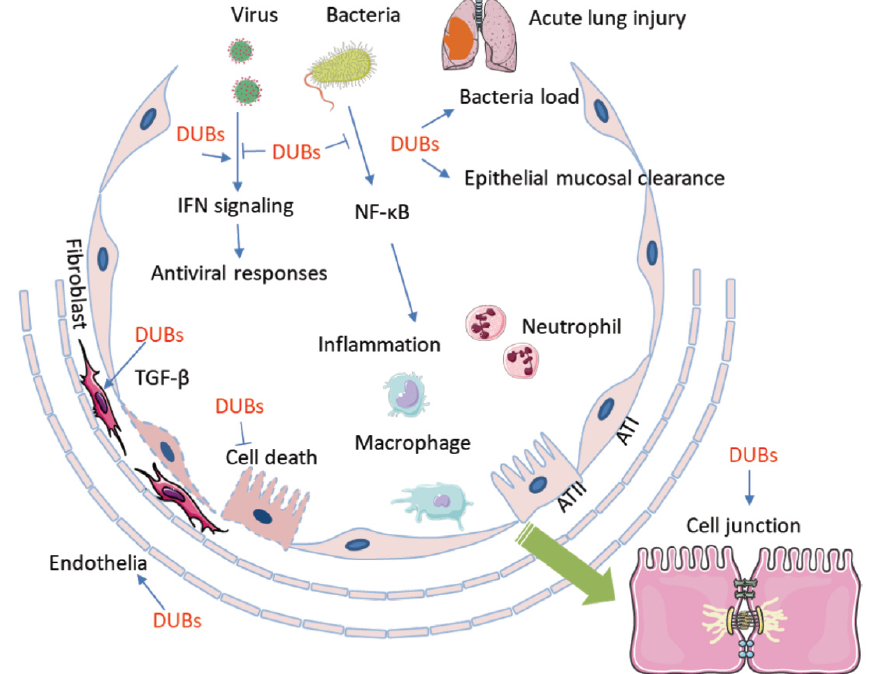
Figure 2. Deubiquitination and DUBs are involved in the pathogenesis of ALI / ARDS. DUBs conduct deubiquitination that is exclusively involved in every aspects of the pathogenesis of ALI / ARDS. Microbial pathogens regulate the activity and availability of DUBs to impact host immune defense and the inflammatory response, which includes chemokine and cytokine release, macrophage activation, and neutrophil and lymphocyte infiltration. On the other hand, DUBs participate in pathogen-mediated lung epithelial and endothelial cell proliferation and death. Furthermore, DUBs may affect epithelial mucosal clearance and regulate the bacterial load in small airway alveolar epithelial cells. In addition, DUBs impair cell junctions and the air–blood barrier. AT1: alveolar type 1 epithelial cell; AT2: alvelolar type 2 epithelial cell; TGF- β : transforming growth factor- β ; DUB: Deubiquinating enzyme.